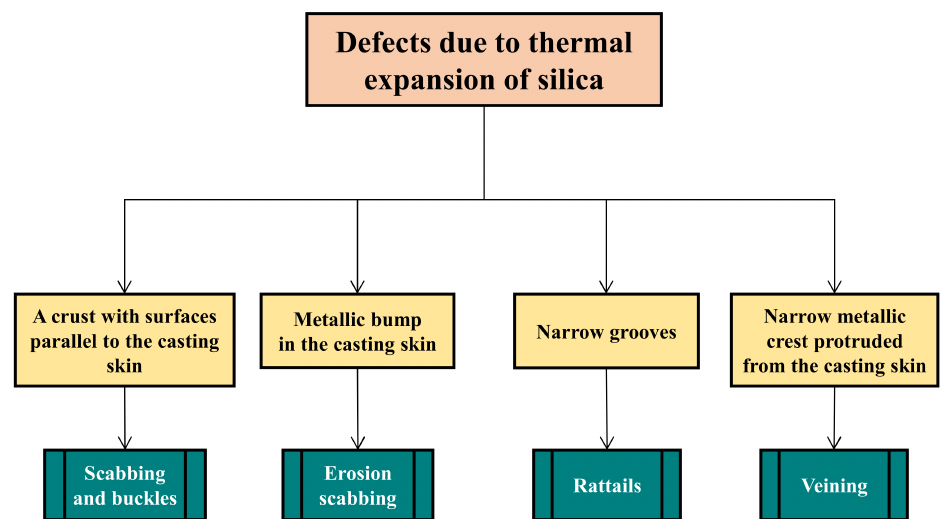
Figure 22. Classification of defects due to silica thermal expansion according to their characteristics under visual